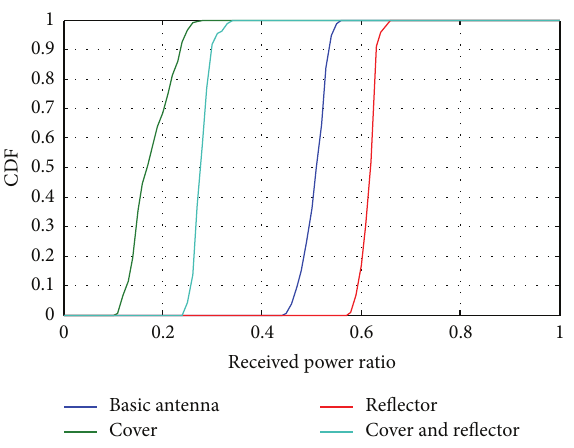
Figure 16: Scatter plot for received power ratio in four types of